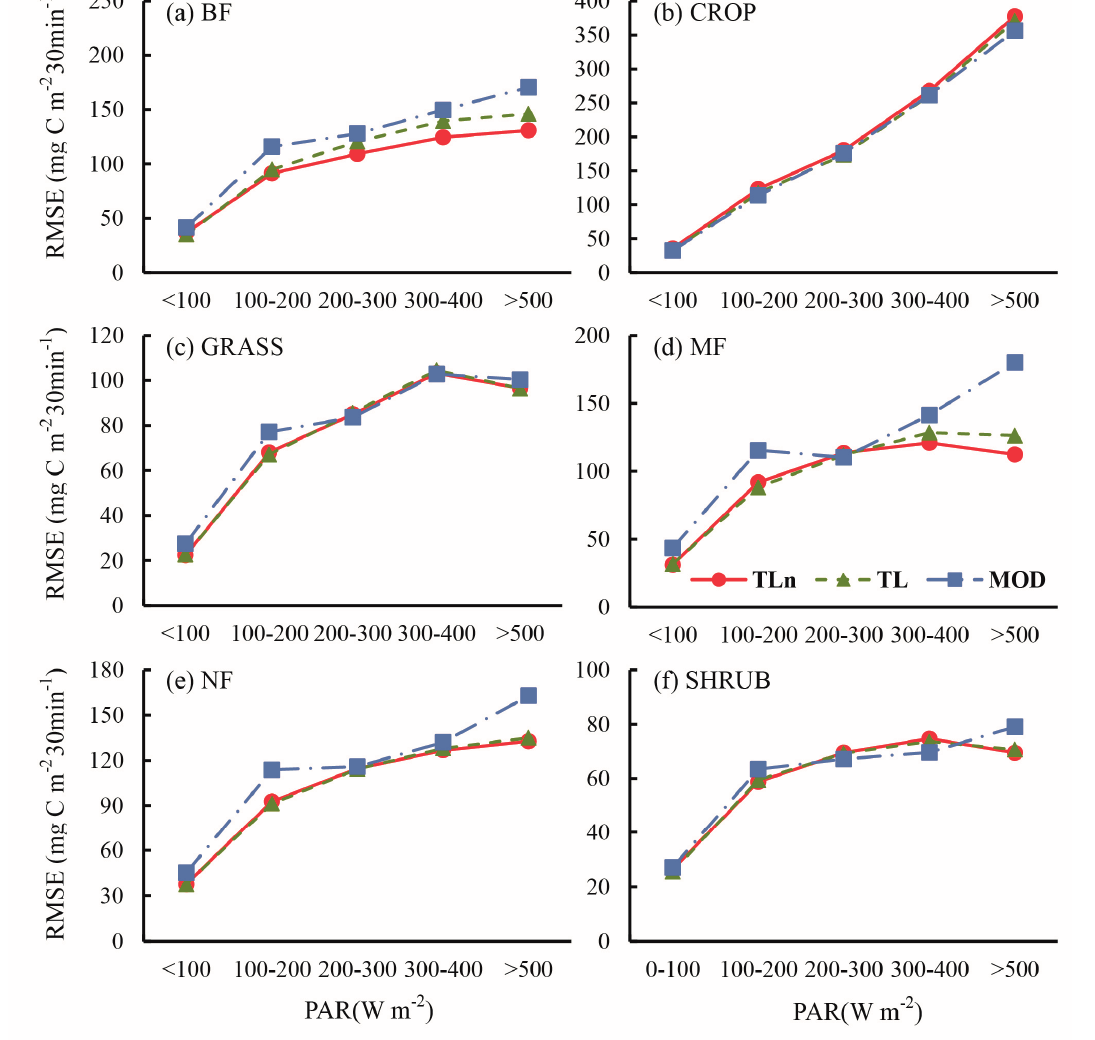
Figure 6. The RMSE of modeled GPP against tower-derived GPP within different photosynthetically active radiation (PAR) classes for six different vegetation types: ( a ) BF, ( b ) CROP, ( c ) GRASS, ( d ) MF, ( e ) NF and ( f ) SHRUB, at the half-hourly